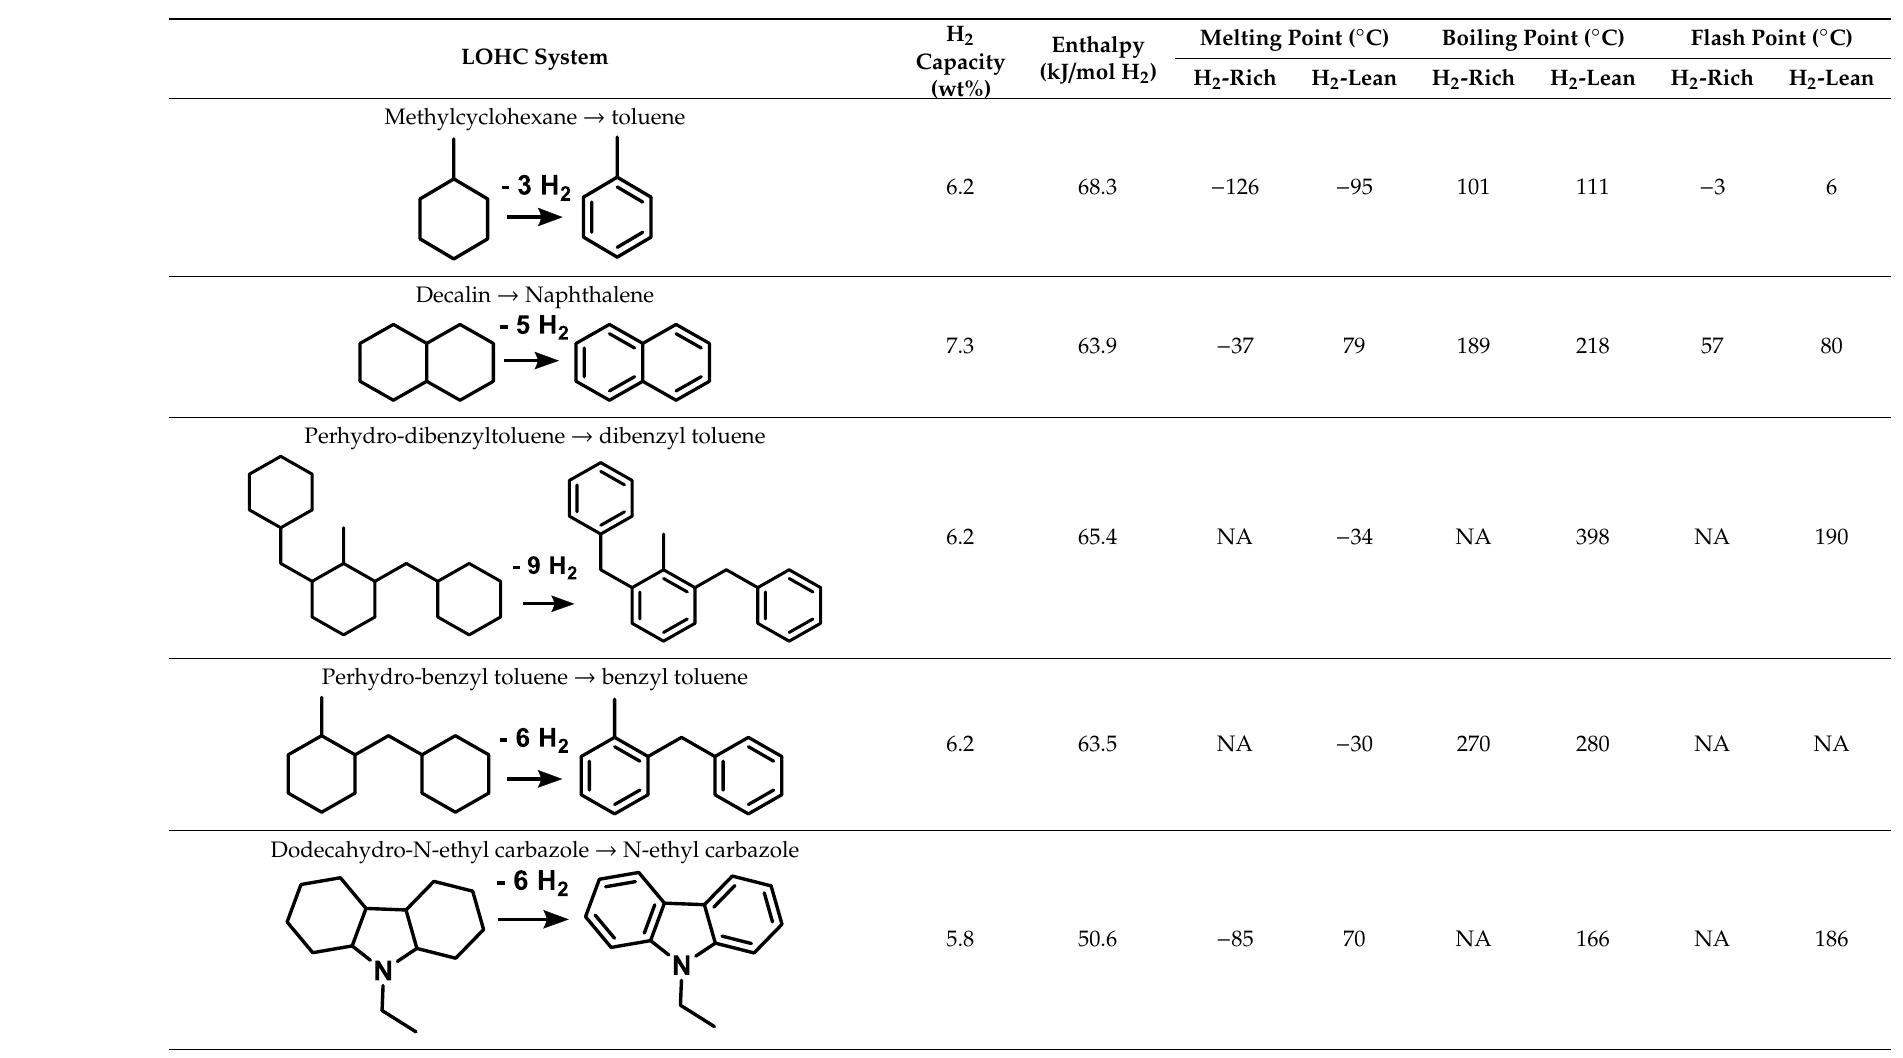
Table 1. Typical examples of potential LOHCs and their physicochemical properties.